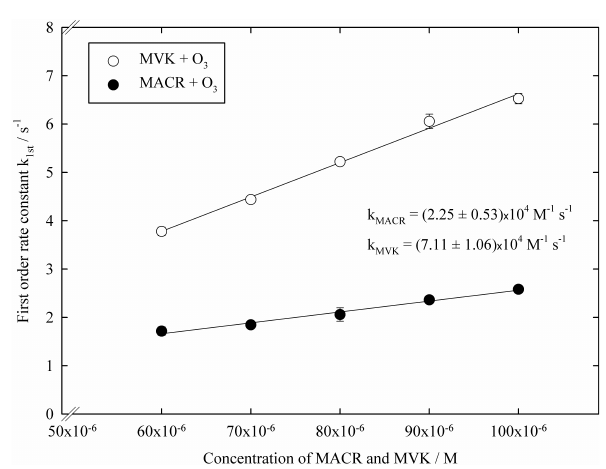
1st plotted over the con-